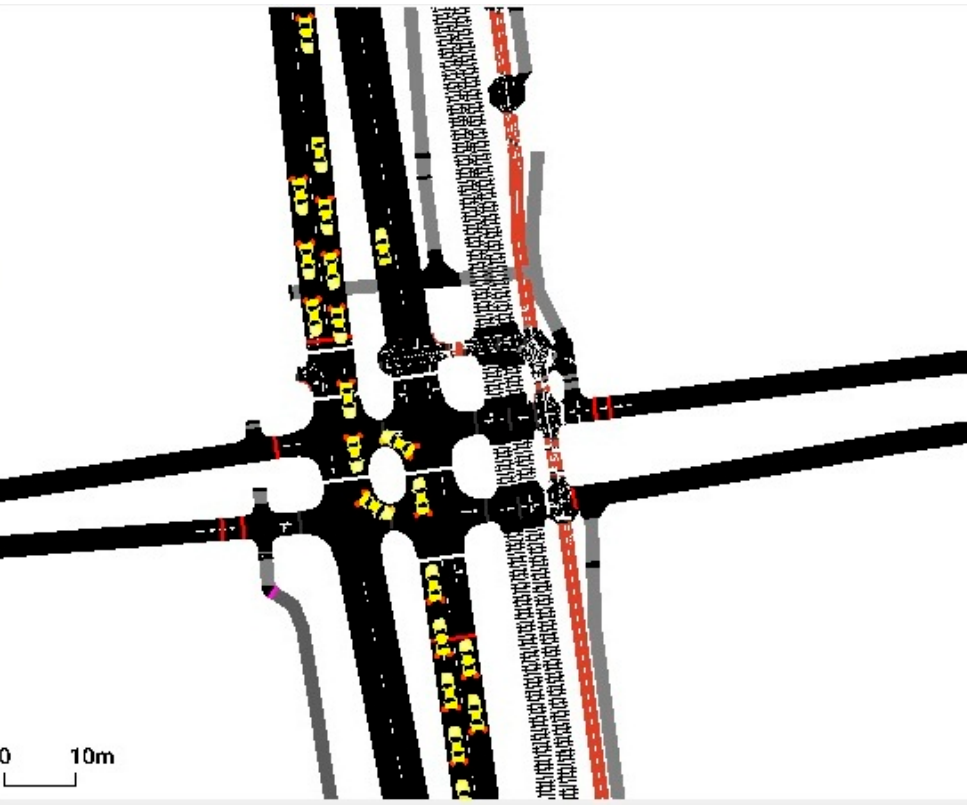
Figure 3. View of intersection before implementation of improvements. Prior to improvements, the generated section contains only one lane, which allows vehicles to drive straight ahead and to make a turn. This reduces the traffic capacity. An additional turn lane would relieve the lane for driving straight